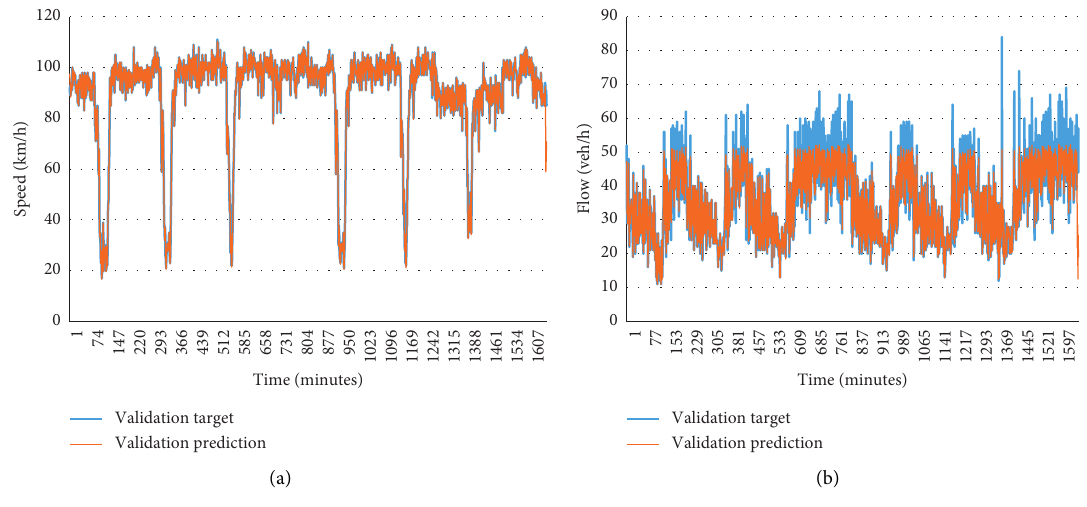
Figure 11: Speed and flow validation results for 5